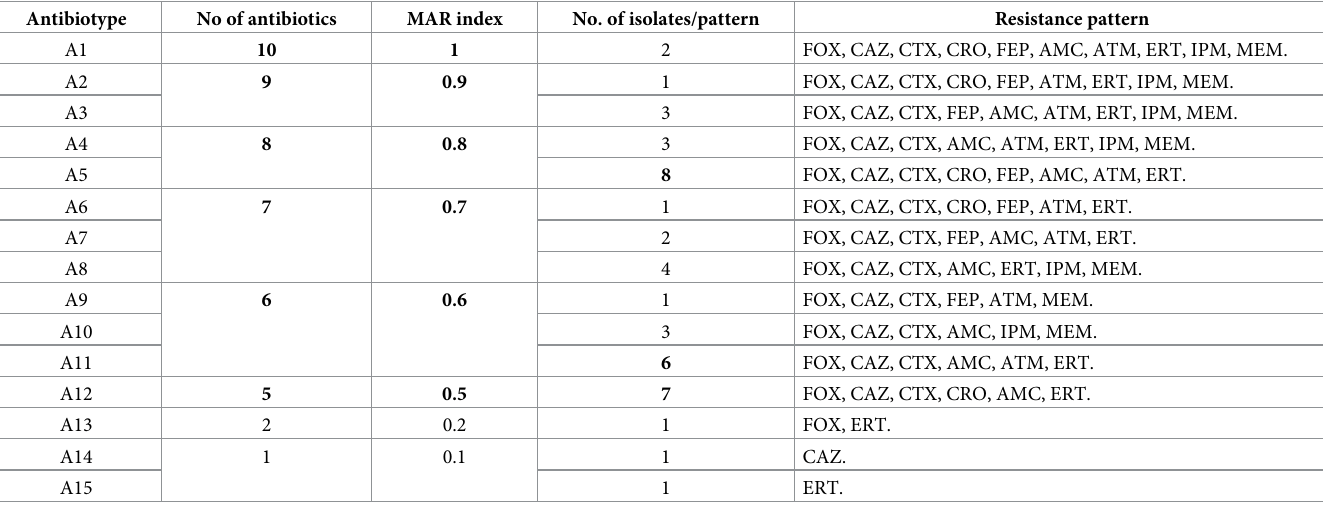
Table 2. Antibiotic resistance patterns of the tested K . pneumoniae isolates.